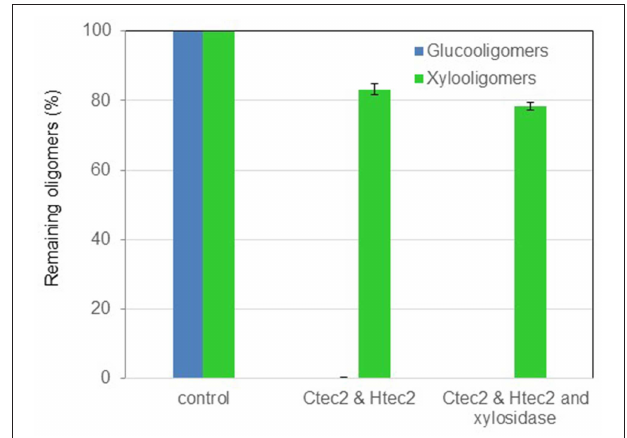
FIGURE 5 | Enzymatic degradation of xylooligomers by Htec2 and β - xylosidase in black liquor.